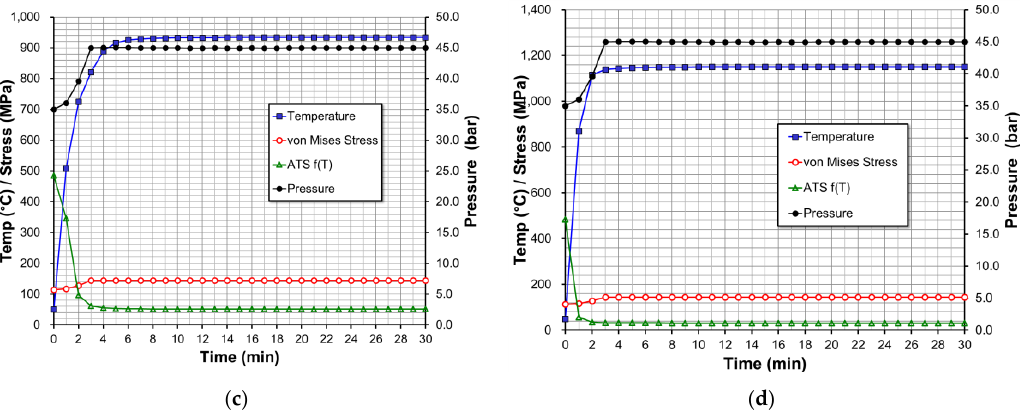
Figure 4. Results for 0.5-m diameter vessel with 45 bar design pressure. The graphs show vessel pressure (right axis), temperature (where peak heat load is applied), von Mises stress and ATS (left axis) as a function of time. ( a ) Pool fire scenario at 15 bar; ( b ) jet fire scenario at 15 bar; ( c ) pool fire scenario at 35 bar; and ( d ) jet fire scenario at 35 bar.